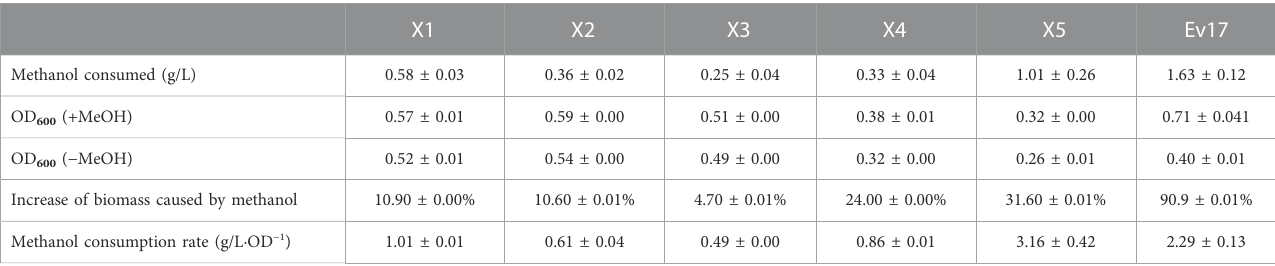
TABLE 2 Growth phenotype and methanol consumption of fi ve strains at 48